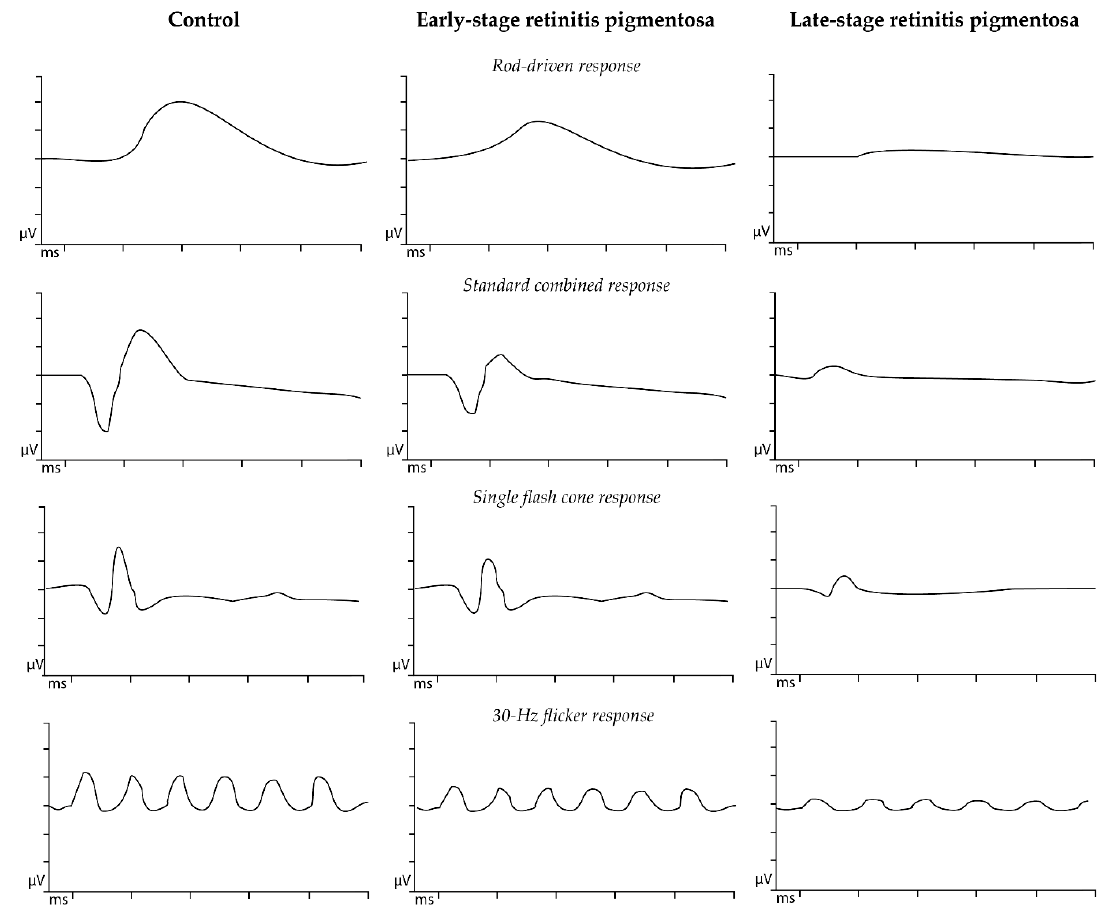
Figure 3. Example full- fi eld electroretinography recordings in a healthy patient and in patients with di ff erent disease stages of retinitis pigmentosa. Di ff erent stimuli are used to establish the diagnosis of retinitis pigmentosa, which is based on the guidelines of the International Society for Clinical Electrophysiology of Vision (ISCEV). In patients with advanced stages of diseases, rod-driven responses are severely diminished or even absent, whereas residual cone-driven responses may still remain.